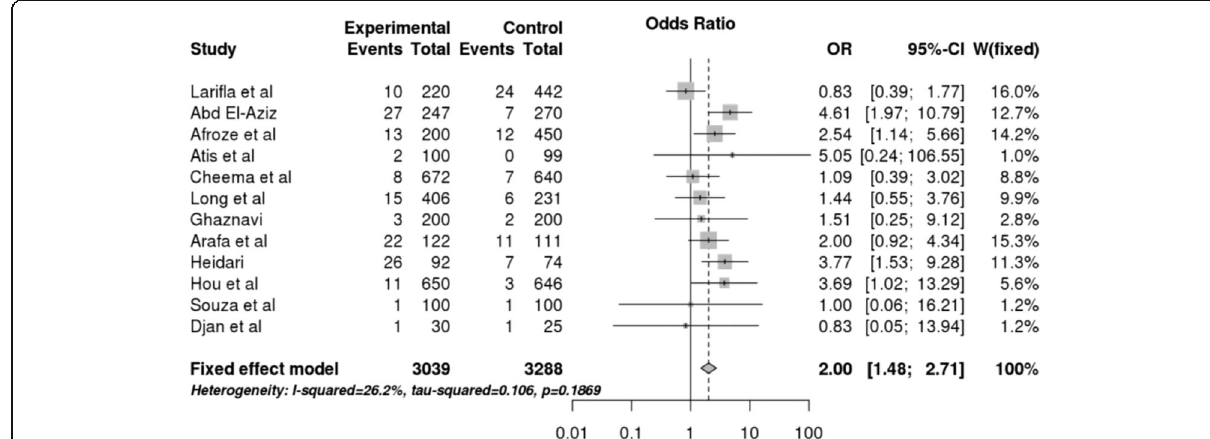
Fig. 3 Forest plot for APOE polymorphism and CAD risk in the genetic model of ε 4 allele analysis